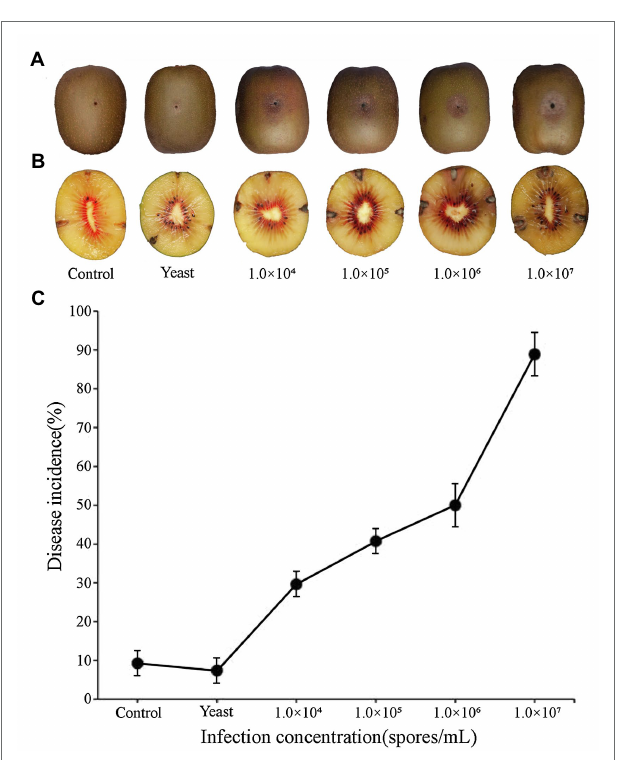
FIGURE 2 | Black spots symptoms on kiwifruit inoculated with different spore concentrations of A. alternata (Y784-BC03). Kiwifruit black spots after 4 days as a result of the inoculation of wounds with different concentrations of A. alternata (Y784-BC03) (A) . Appearance of mycelia in kiwifruit black spot infection sites (B) . A. alternata (Y784-BC03) disease incidence associated with the inoculation of wounded fruit with different concentrations of spores (C) .